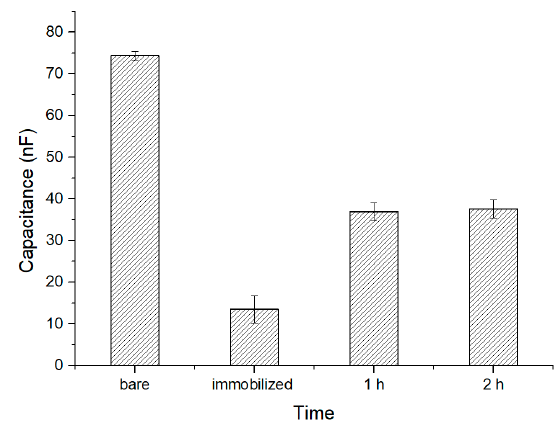
Figure 7. Capacitance values at different periods in a cell solution of 10 5 CFU ∙ mL − 1 .